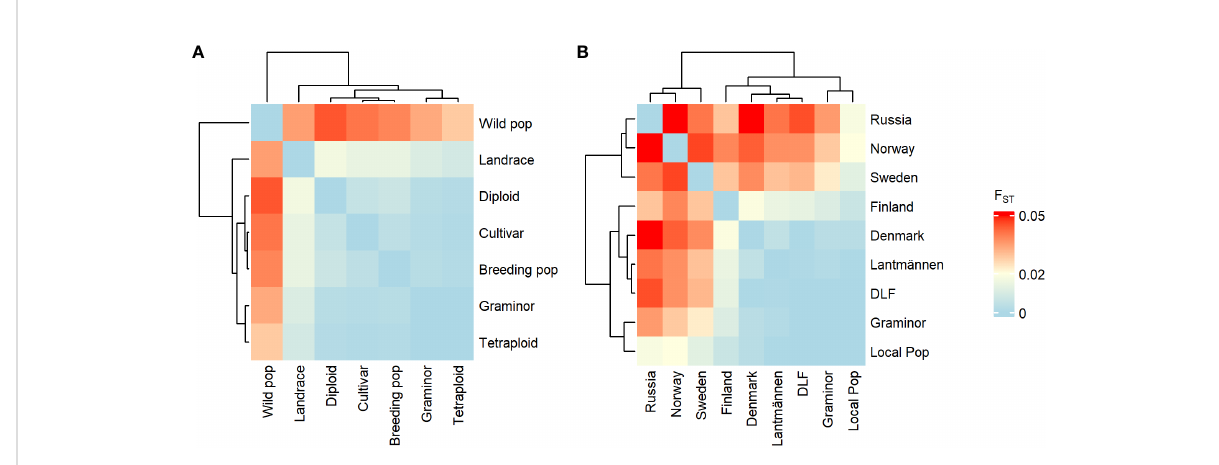
FIGURE 2 Heatmap depicting the pairwise F ST values between groups of red clover populations based on population type (A) or origin (B)